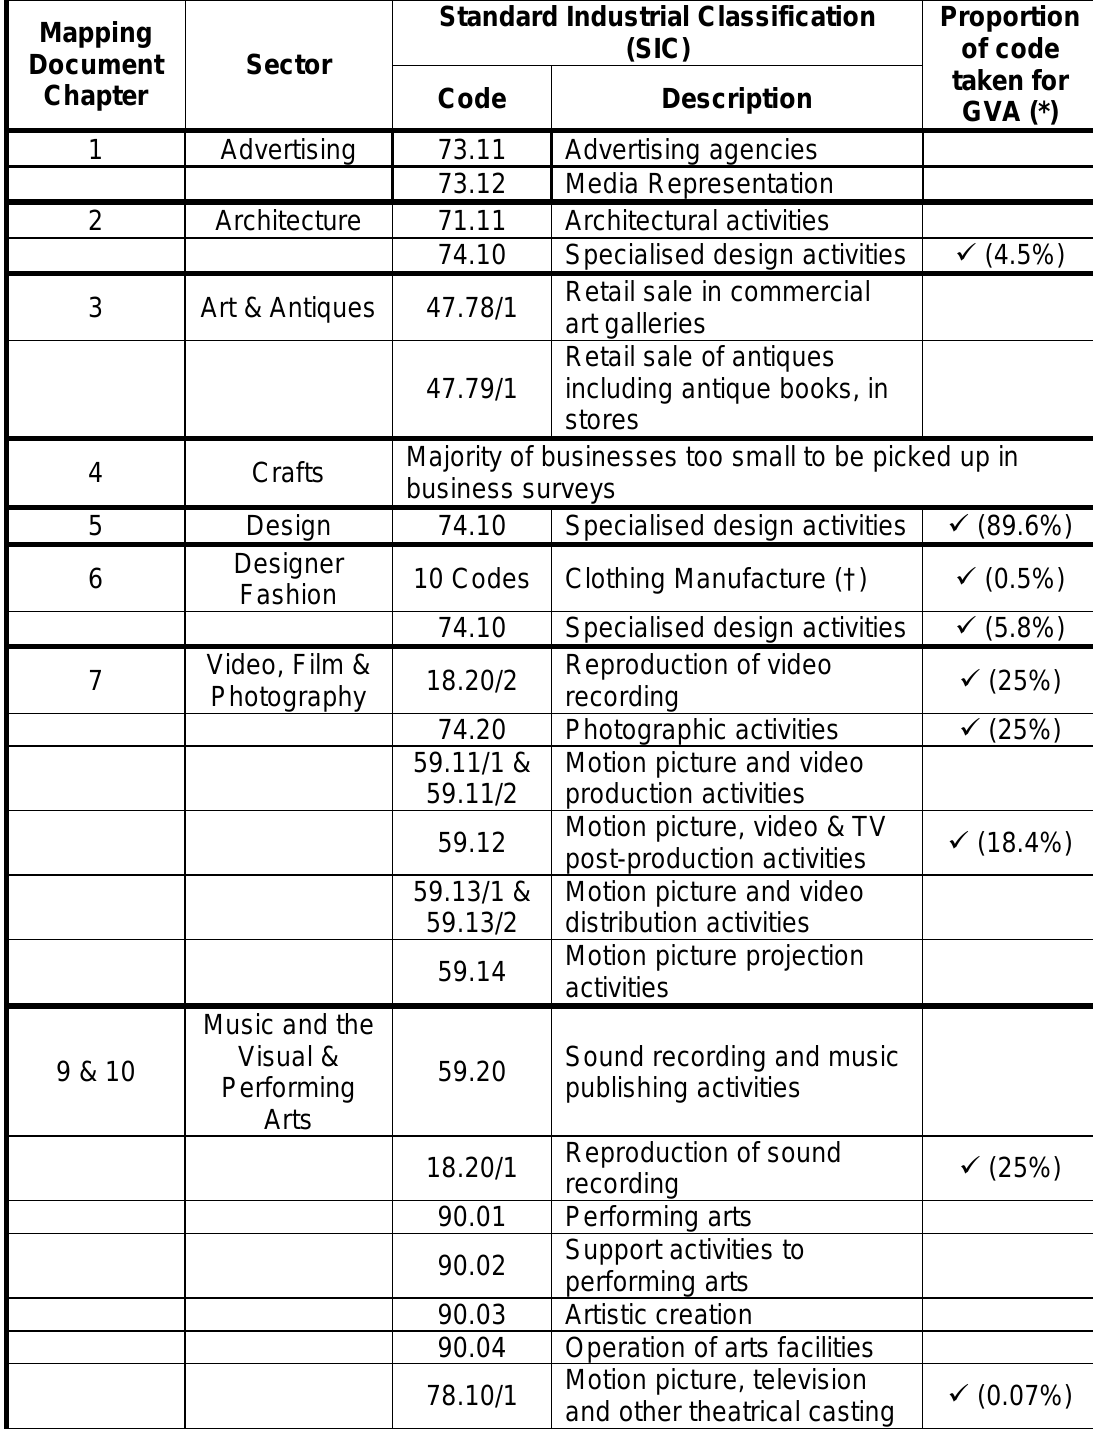
Table A1 – Mapping of the Creative Industries to the 2007 Standard Industrial Classification (SIC) for Annual Business Survey (ABS)